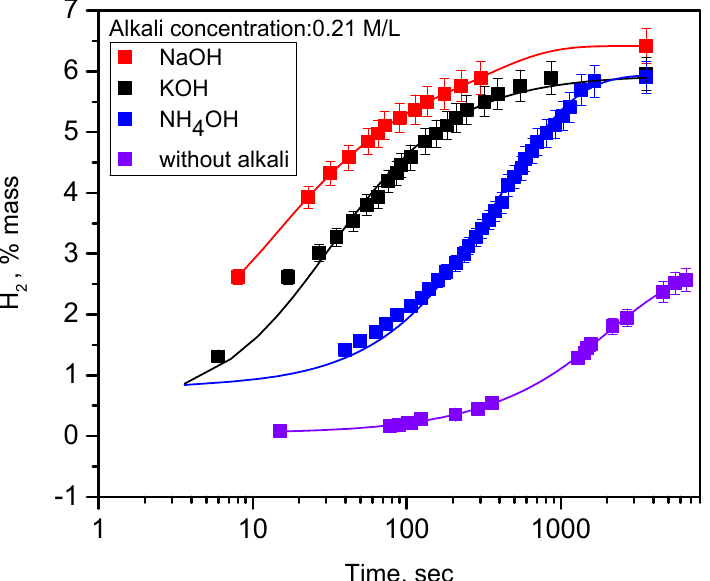
Figure 5. Kinetics of hydrogen generation due to oxidation reaction of meso-PSi nanopowders in water:ethanol:alkali solutions at room temperatures. Concentration of the used alkalis was 0.21 M/L. Discrete points correspond to experimentally measured values, while solid lines are the fitting functions given in Supplementary Materials.